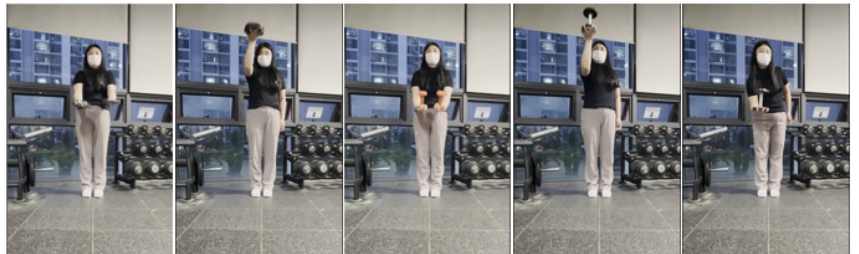
Figure 3. Experimental scene of measuring the speed of one-hand raising by weight in real space.